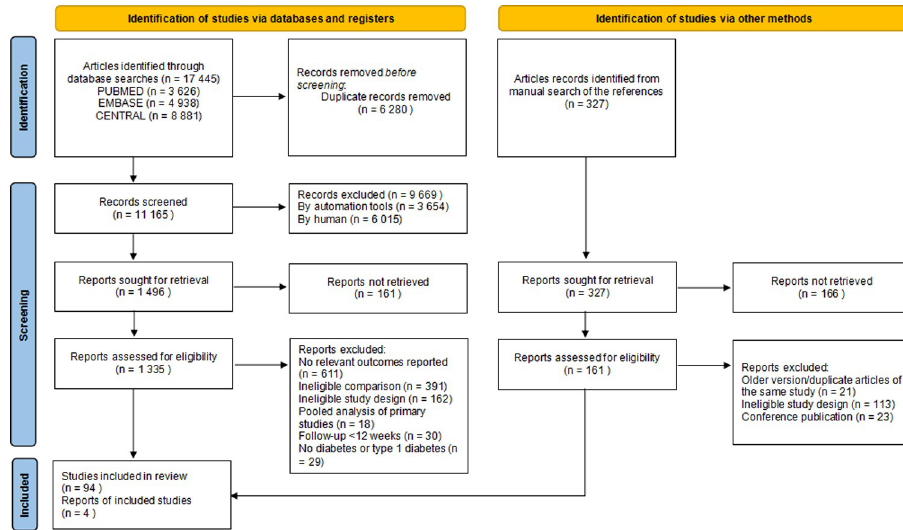
Fig 1. Summary of study retrieval and identification for network